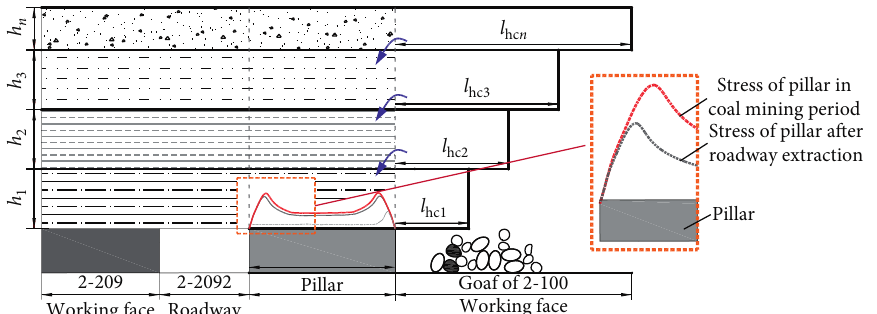
Figure 5: Mechanical model of the coal pillar side in 2-2092